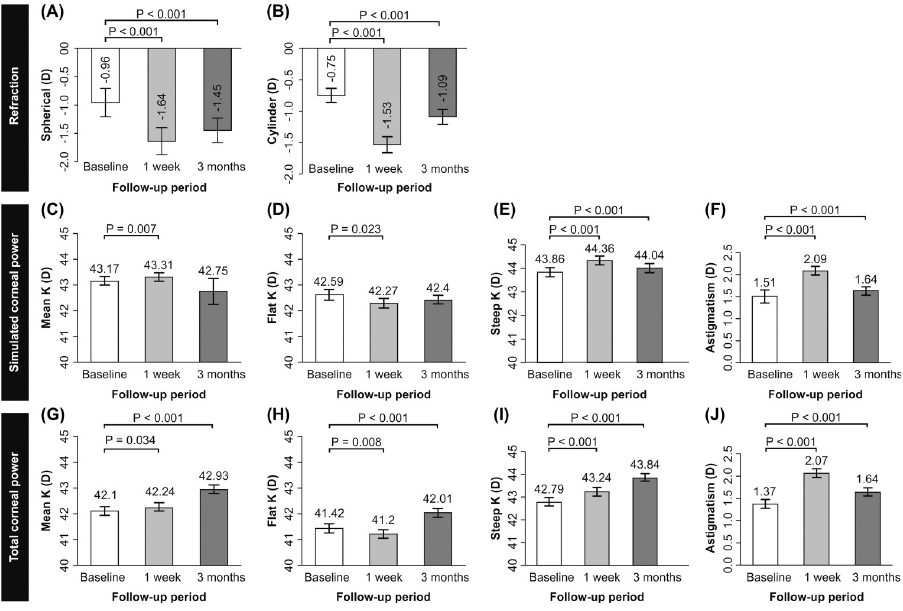
Fig 1. Change in refraction, simulated and total corneal power according to follow-up time. Data expressed as mean ± standard error. D: diopter; K: keratometry.